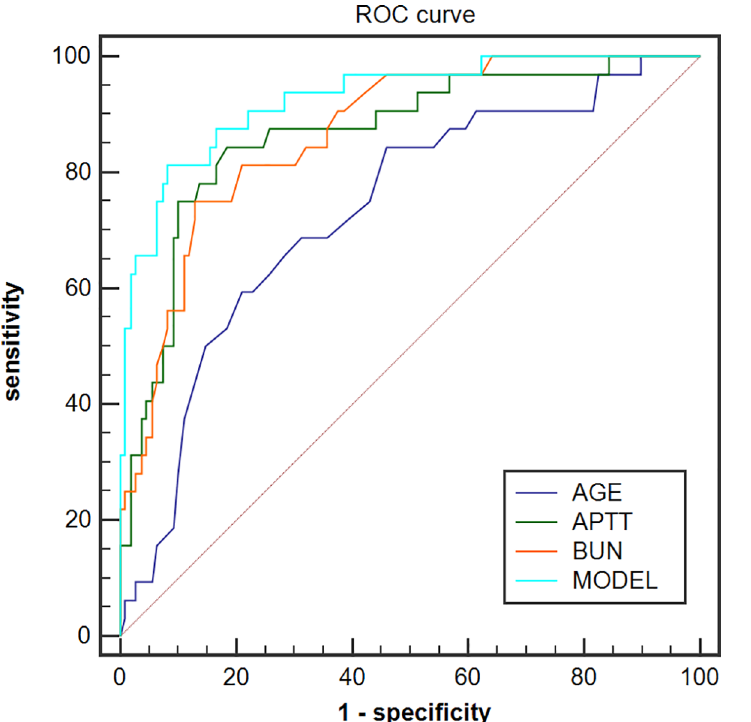
Fig 2. ROC curve for the prediction of mortality of SFTS patients.